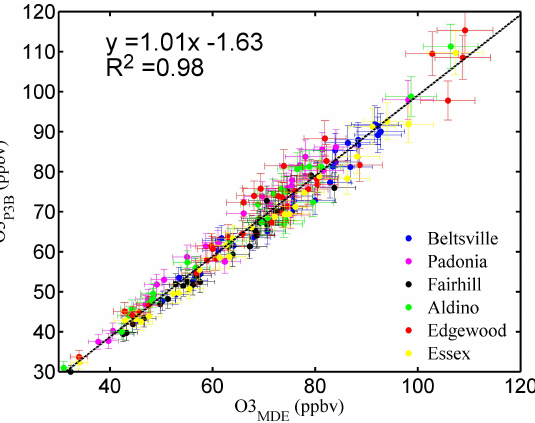
Fig. 3. AOD measured by AERONET as a function of AOD re- trieved from the P-3B extinction measurements for three wave- lengths (440, 500 and 675nm, respectively blue, green and red). The error bar depicts the instrumental variability for the AOD calculated from the P-3B measurements and ± 0.02 for the AOD measured by AERONET (Holben et al.,